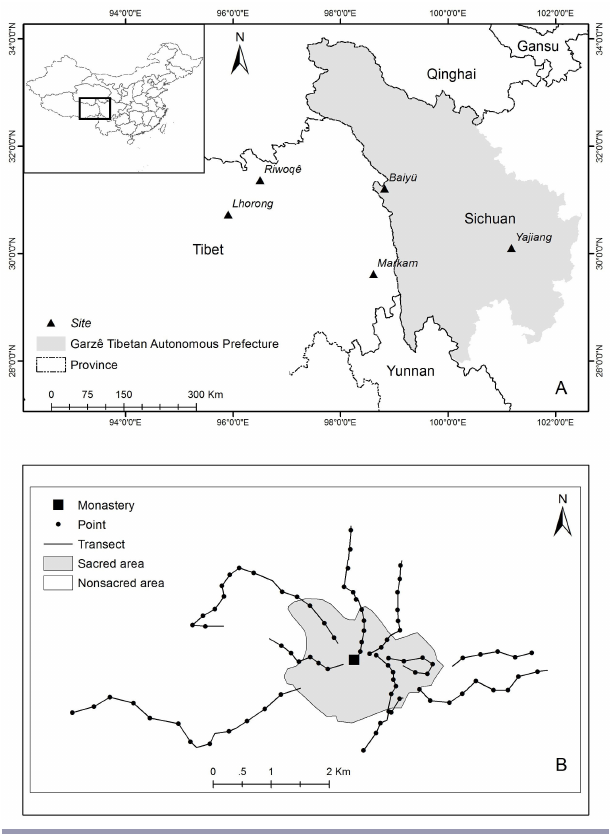
Fig. 1 . Map showing (A) locations of published studies for estimating index of Buff-throated Partridge ( Tetraophasis szechenyii ) abundance, and (B) our study area (Pamuling) in Yajiang County, Garzê Tibetan Autonomous Prefecture, Sichuan, western